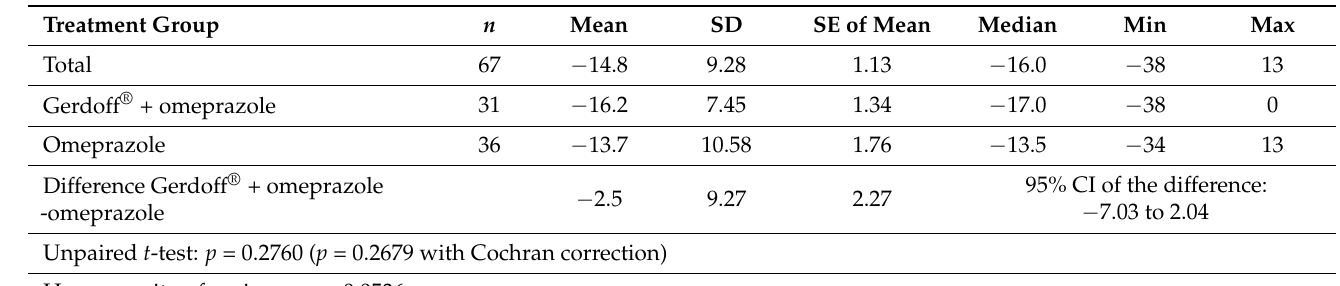
Table 3. Summary of results for the primary performance endpoint (change in total RSI score between baseline and week 6).